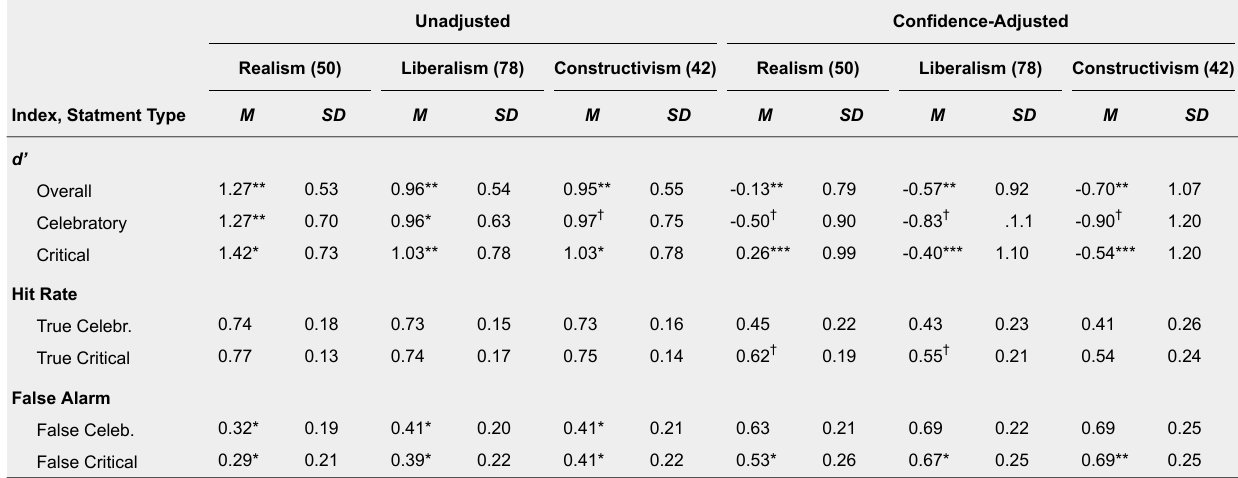
Differences in d’ (or Accurate Attunement to U.S. Foreign Policy